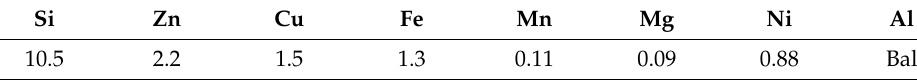
Table 1. Chemical composition of ADC12